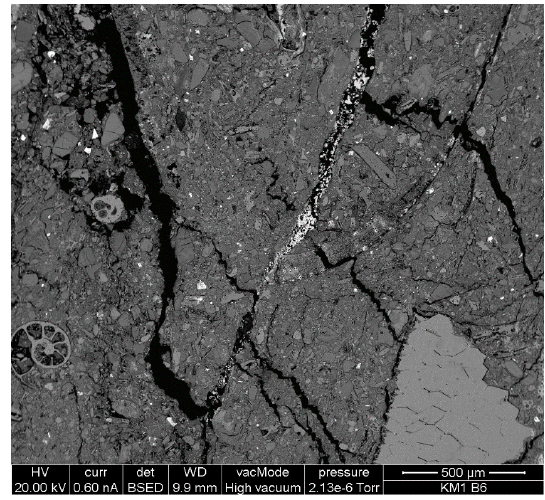
Figure 12. BSEM image of some of the major faults within sample KM1 B6. Most here form a network of straight conjugate faults, but a curved listric fault crosses the centre of the image (Plate C39 in Supplementary Materials Section S3).